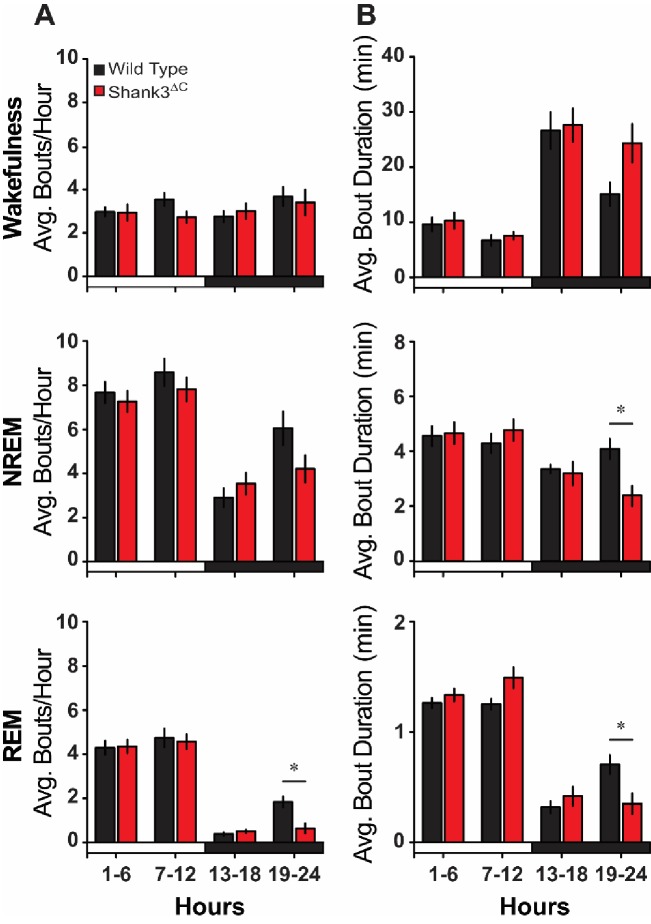
Baseline sleep bout analysis.(A) Average number of state-specific bouts per hour shown in 6 hr blocks. (B) Average bout duration (min) per hour shown in 6 hr blocks. Repeated measures ANOVA with posthoc pairwise comparisons using Sidak correction. Values are means ± SEM for wild type (n = 10) and Shank3∆C (n = 10) mice. *p<0.05, difference from wild type.